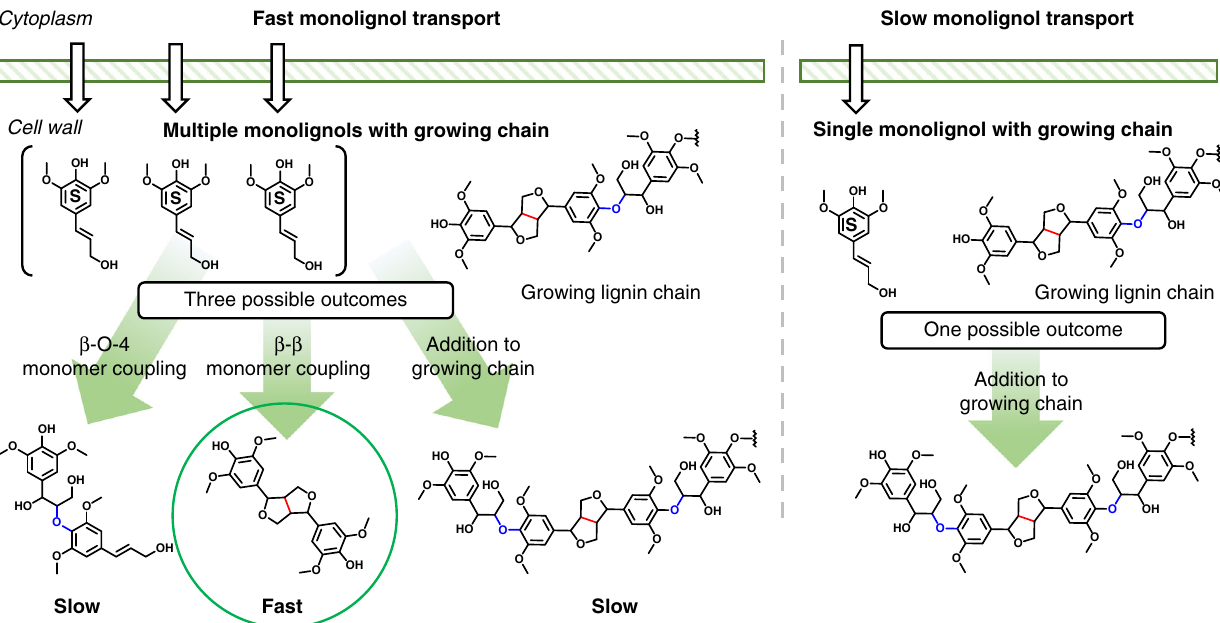
Fig. 6 Illustration of monomer concentration in fl uence on bond formation during ligni fi cation. In the case of fast monomer transport from the cytoplasm to the cell wall, monomers can couple together to form dimers, or add to growing lignin chains. In the case of slow monomer transport, if an S monomer can only add to a growing chain that already contains a β - β bond, it must form a β -O-4 ether